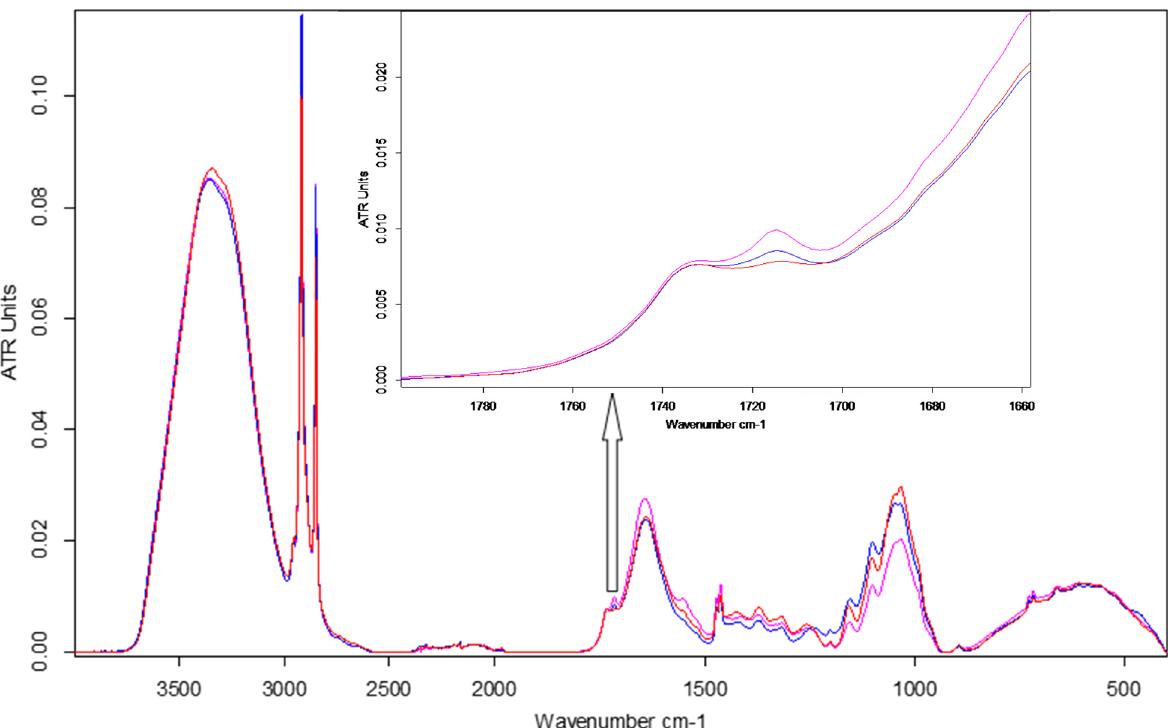
Figure 10. FTIR spectra of maize leaves: control, ESPE, and VALKE with details of the phenolic ester band at 1715 cm − 1.